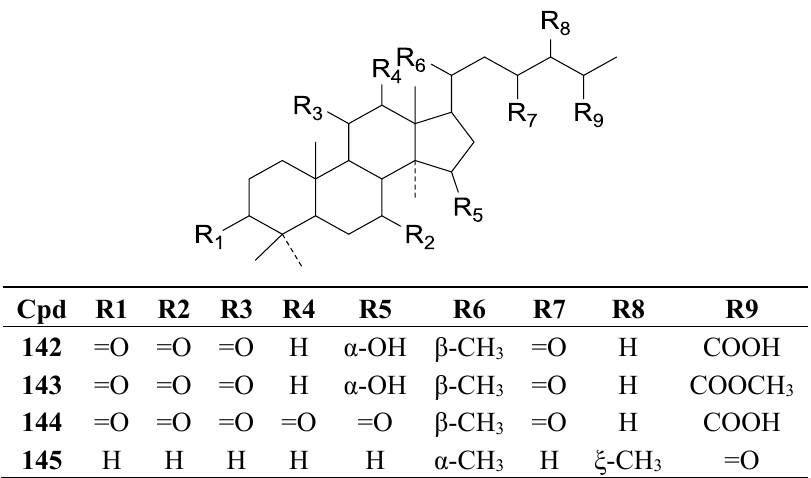
Figure 16. Structures of compounds 142 ‒ 145 .